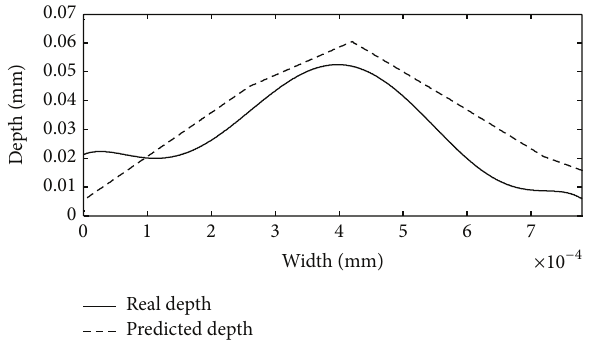
Figure 10: Real and predicted depth through the transversal section 𝑇 󸀠 used for the external validation of the